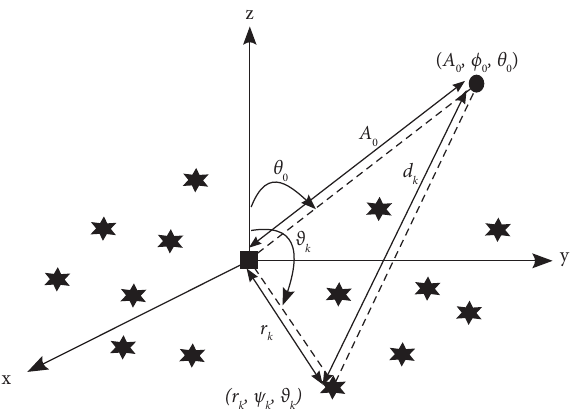
Figure 1: Wireless sensor network model (a 3-dimensional per- spective from the point of view of both node distribution and sink location). Cluster head: rectangular symbol; sensor nodes: star symbol; sink: circular symbol.